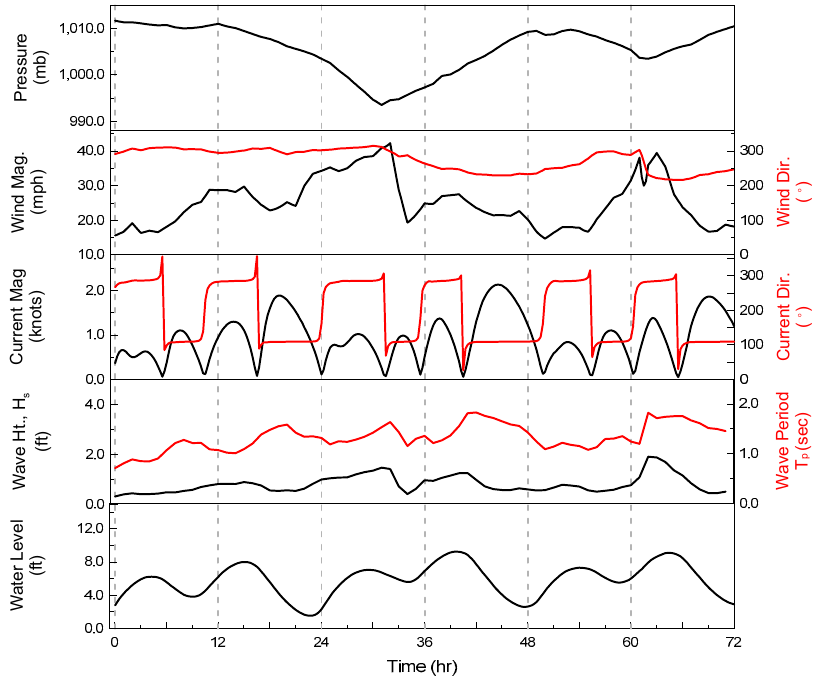
Figure 6. Time series output from the coastal component of Hydro-CoSMoS at the Napa River mouth for the storm scenario described in the text (from [25]).